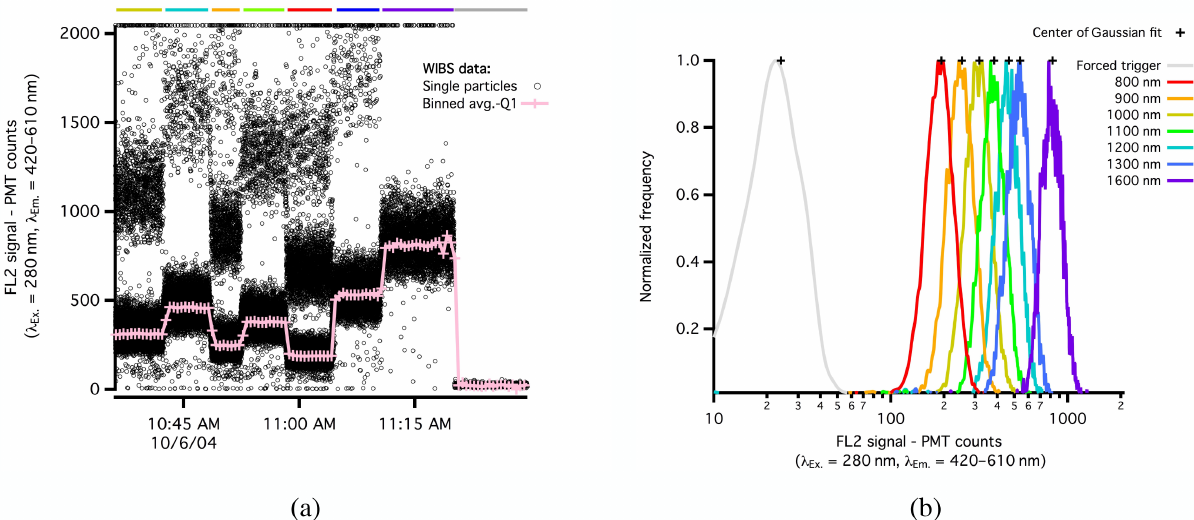
Figure 3. Example time series data for calibration experiments illustrated by showing (a) FL2 WIBS data points for different sizes of mobility-selected particles and (b) histograms of singly charged fluorescent calibration particles. Colored bands at the top of (a) correspond to the selected particle sizes shown in the legend of (b) . This example illustrates the typical timeline of a calibration experiment for quinine and how we analyze the data to construct calibration curves (shown in Fig. 4). Only singly charged particles were used to construct the calibration